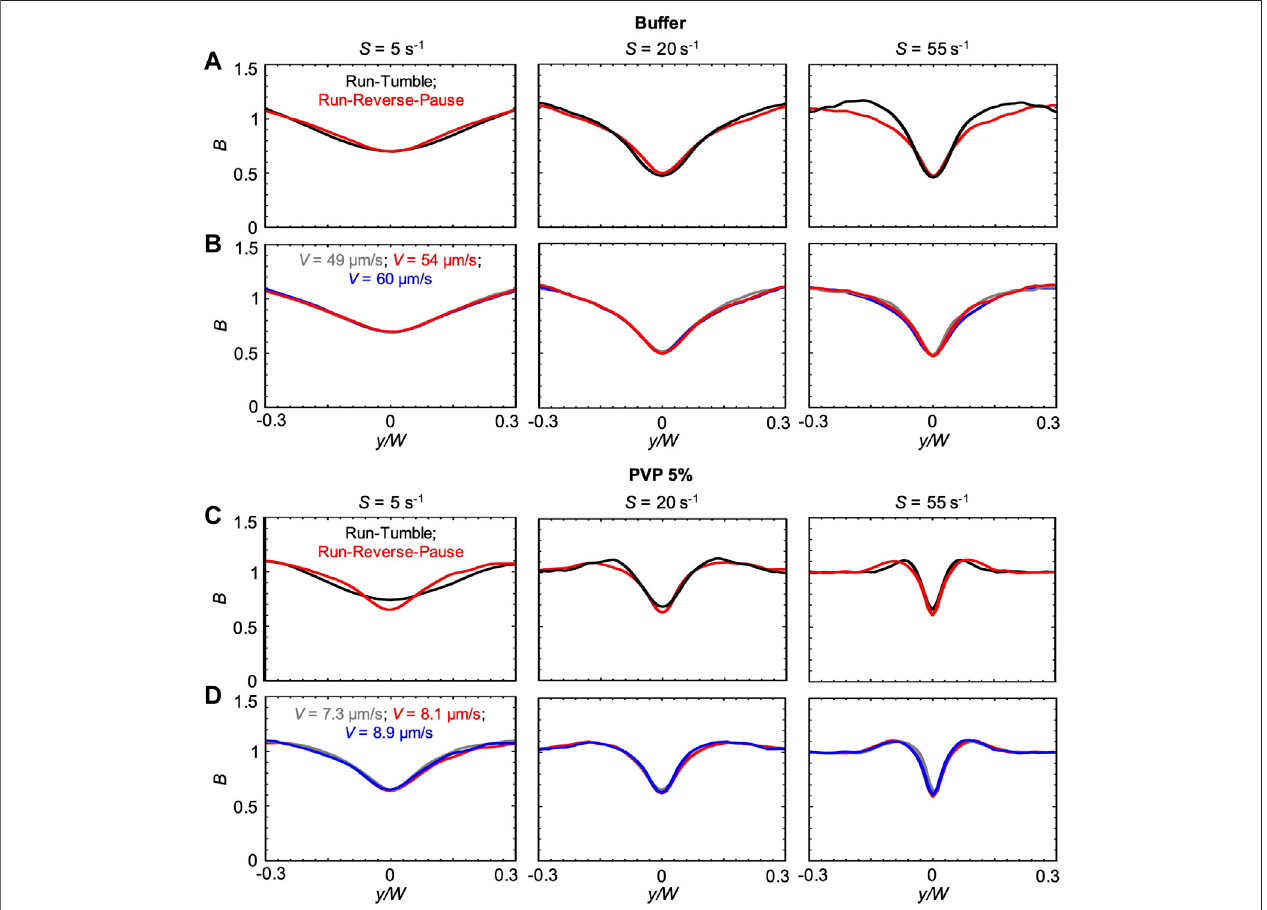
FIGURE 5 | (A) Bacterial concentration pro fi les B numerically calculated according to the mathematical model for mean shear rates S = 5 s − 1 (left), S = 20 s − 1 (center)and S =55 s − 1 (right)inbuffer,atadistance D =50 cmforswimmerswithrun-tumble(black)andrun-reverse-pause(red)patterns.Fortherun-tumbleswimmers we used q = 9.4, V = 54.17, μ ms − 1 , and D R = 1.4 rad 2 s − 1 as in [29], while the run-reverse-pause swimmers were simulated as described in the Materials and Methods. (B) Bacterialconcentrationpro fi les B calculatedaccordingtothemathematical model formeanshearrates S =5 s − 1 (left), S =20 s − 1 (center) and S =55 s − 1 (right) in buffer for run-reverse-pause swimmers with a swimming velocity of V = 49 μ ms − 1 (grey), 54.17 μ ms − 1 (red) and 60 μ ms − 1 (blue). (C) Bacterial concentration pro fi les B numerically calculated according to the mathematical model for mean shear rates S = 5 s − 1 (left), S = 20 s − 1 (center) and S = 55 s − 1 (right) in PVP 360 5 w/v %, at a distance D = 50 cm from the inlet for swimmers with run-tumble (black) and run-reverse-pause (red) patterns. For the run-tumble swimmers we used q = 9.4, V = 8.1, μ ms − 1 , and D R = 1.4 rad 2 s − 1 as in [29], while the run-reverse-pause swimmers were simulated as described in the Materials and Methods. (D) Bacterial concentrationpro fi les B calculatedaccordingtothemathematicalmodelformeanshearrates S =5 s − 1 (left), S =20 s − 1 (center)and S =55 s − 1